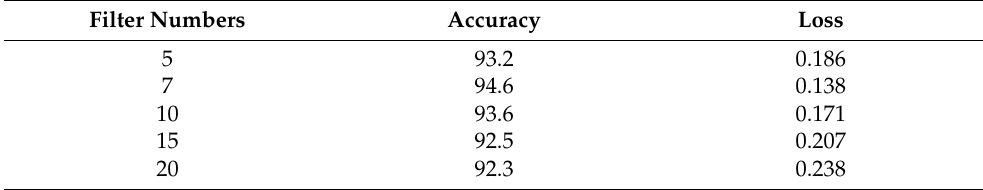
Table 3. Comparison of different filter numbers in the Attention-TCN-BiGRU.